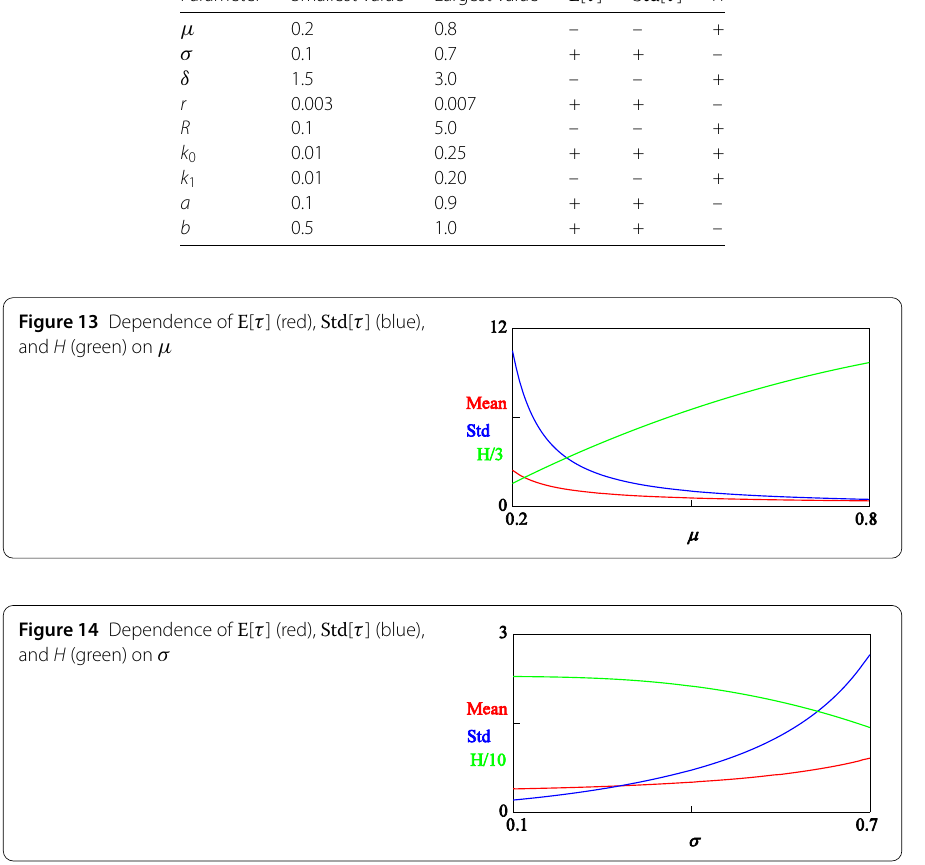
Table 3 Parameter dependence of the E [ τ ], Std [ τ ], and H The notations “+” and “–” mean increase and decrease of these indices Parameter Smallest value